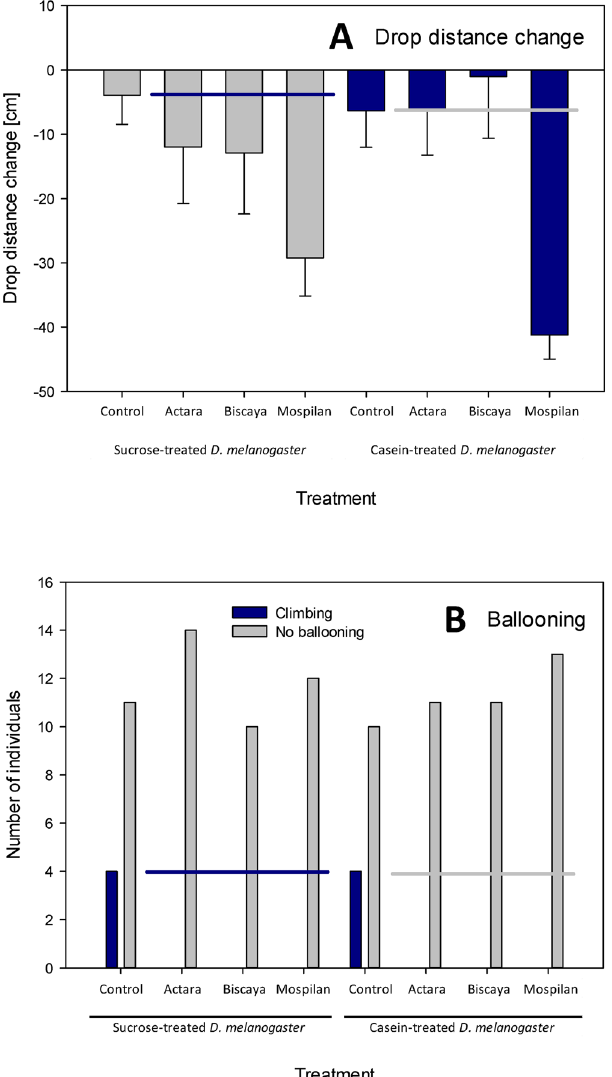
Figure 4. Effects of dietary intervention and treatment with neonicotinoid insecticides on rappelling and ballooning behaviors. ( A ) Change in drop distance. ( B ) Ballooning behavior. Horizontal lines indicate mean control